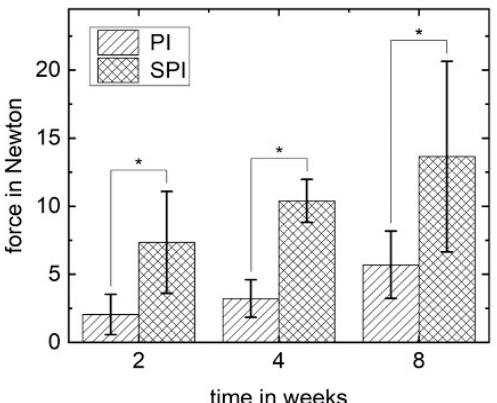
Figure 4. Results of the pull-out test for PI and SPI groups. The pull-out force (mean values in Newton) is pictured with standard deviation. The mean values for SPI were significantly higher for each time point (* p < 0.01).